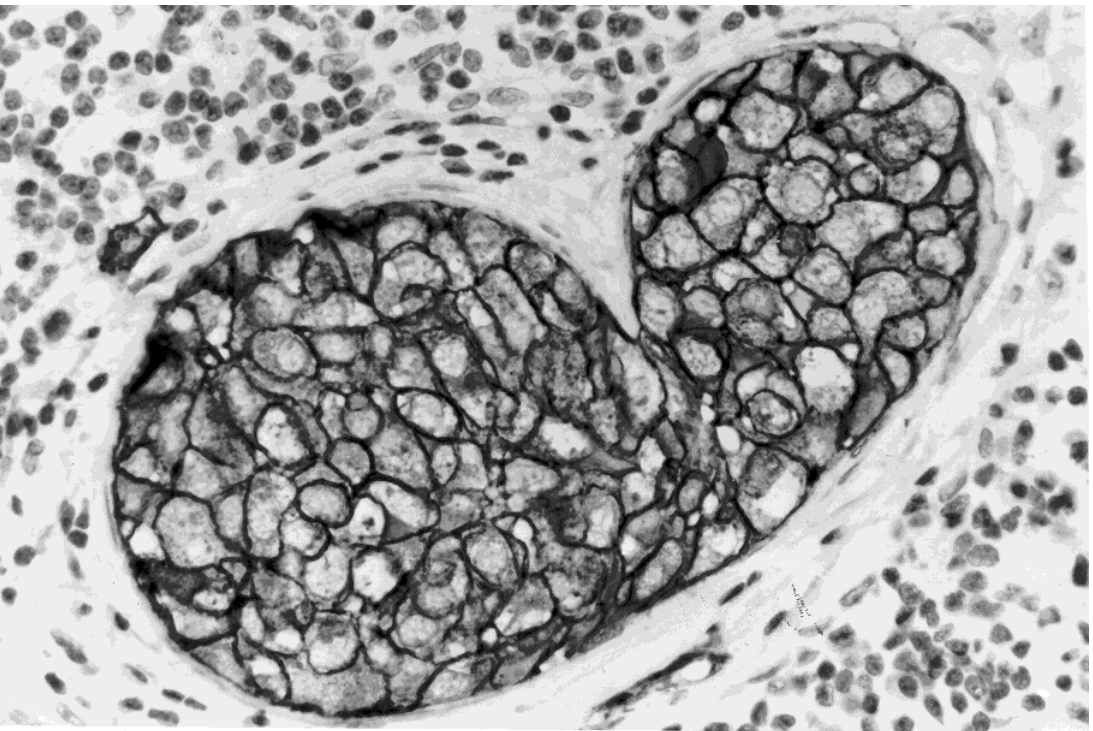
Fig. 2. Immunoreactivity for c-erbB-2 in a ductal invasive carcinoma of the breast. It is evident a cell membrane staining pattern (original magnification × 400).